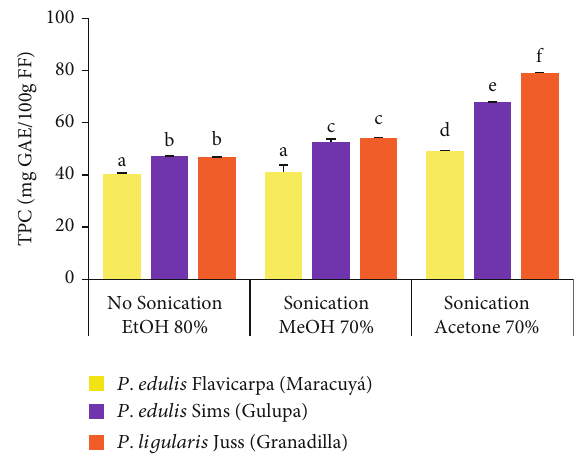
Figure 3: Comparative total phenolic content (TPC) in Colombian Passi fl oras extracted with di ff erent solvents and utilizing alternative extraction conditions. Di ff erent lower-case letters represent statistical di ff erences, for means ± SD based ( n = 3 ), according to ANOVA followed by Tukey ’ s HSD test ( p < 0 : 05